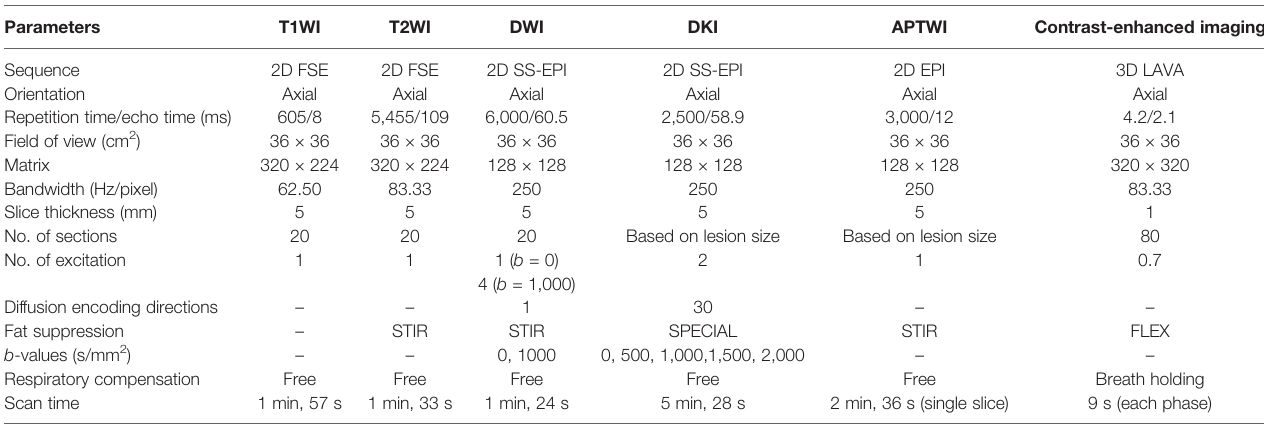
TABLE 1 | Imaging protocol parameters.